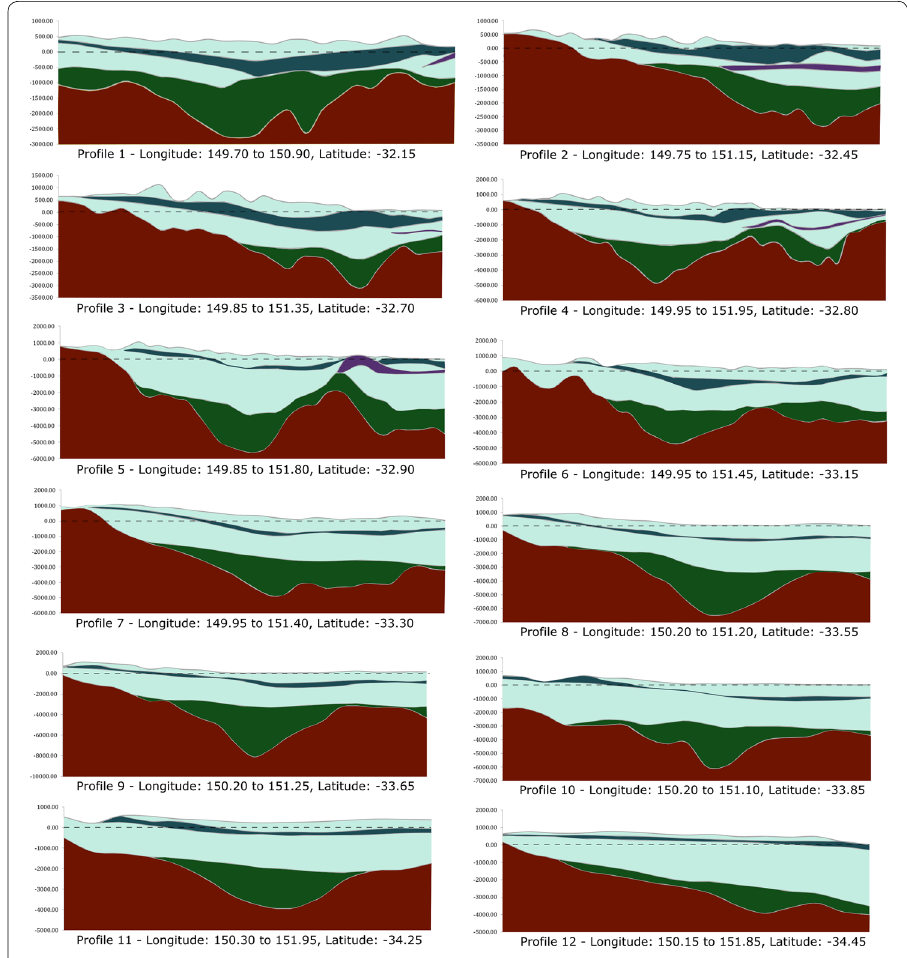
Fig. 6 Crustal structure of the Sydney Basin, from the model of Danis et al. (2012). Latitudes and longitudes of each profile are labelled, and correspond to the lines shown in Fig. 5. Cyan region: Sediment layer, dark blue region: permian coal layer, purple region: greta coal layer, dark green region: volcanics layer, bordeaux region: basement layer. Basement layer extends down to 12 km in thermal